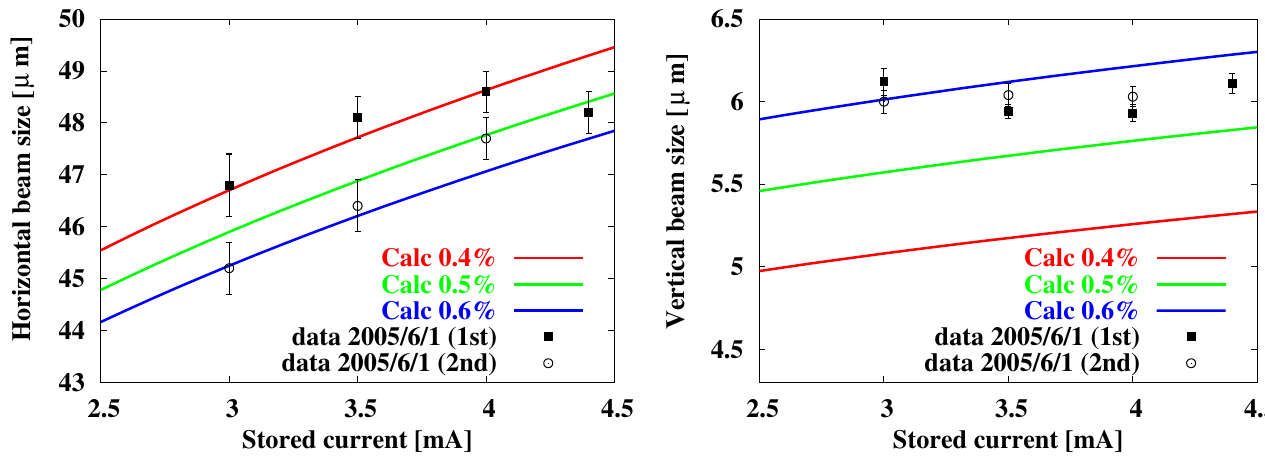
FIG. 17. (Color) Measured beam size taken on 2005 = 6 = 1 by the FZP monitor vs beam current in the single-bunch mode. The lines are from a calculation with intrabeam scattering, assuming coupling ratios of 0 : 4% , 0 : 5% , and 0 : 6%